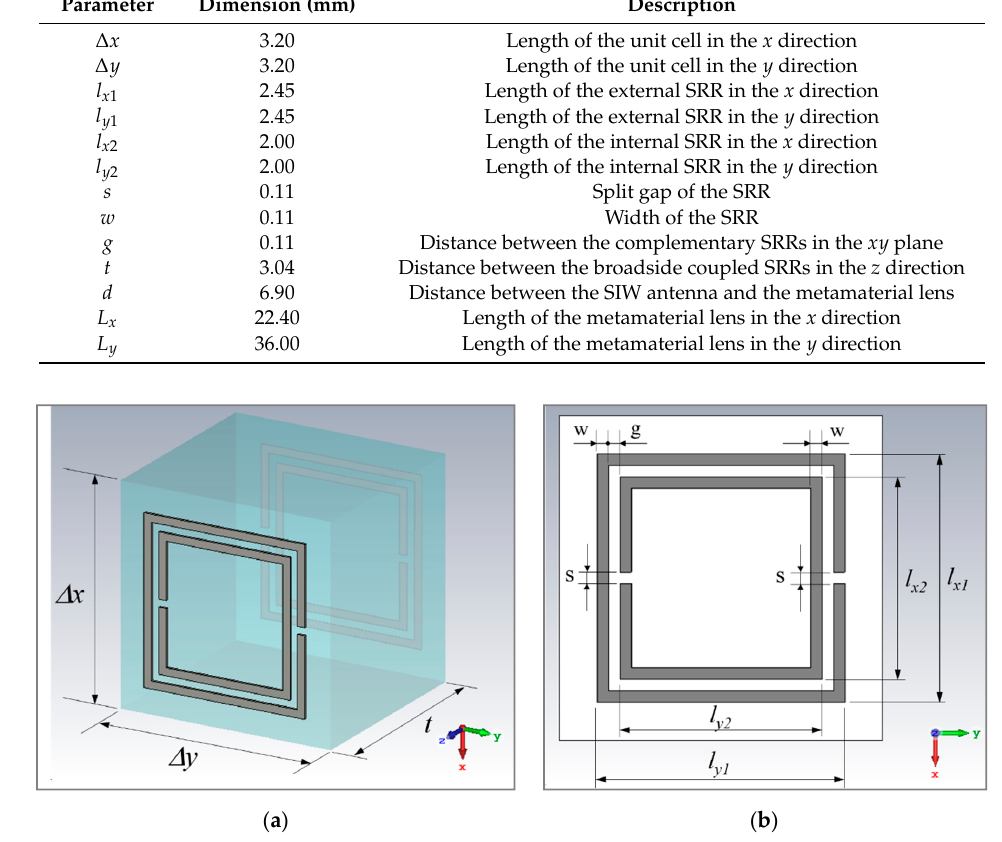
Figure 4. 3D model of complementary broadside coupled SRR unit cell designed in CST Microwave Studio ® . ( a ) 3D view and ( b ) top view.